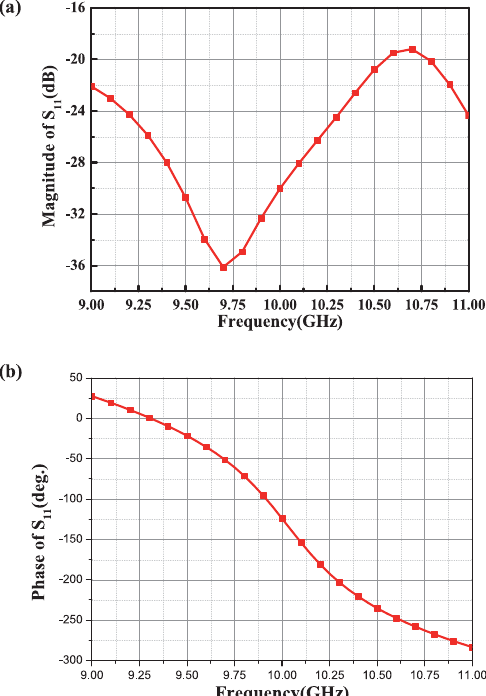
Fig. 5. The re fl ection coef fi cient of the MNMS unit, (a) the magnitude of S 11 , (b) the phase of S 11 .